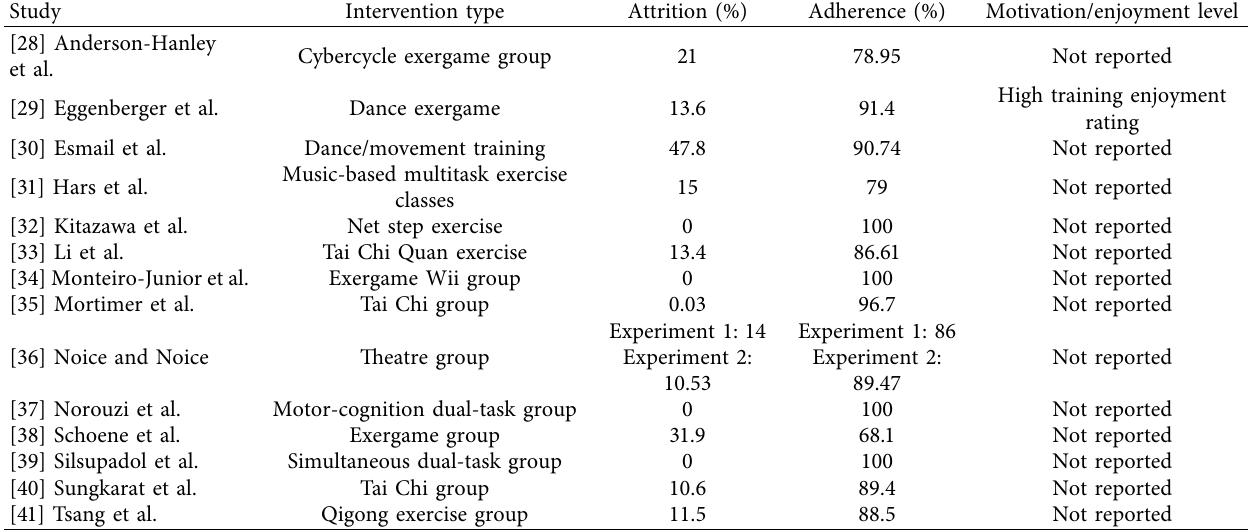
Table 5: Indicators of engagement in the